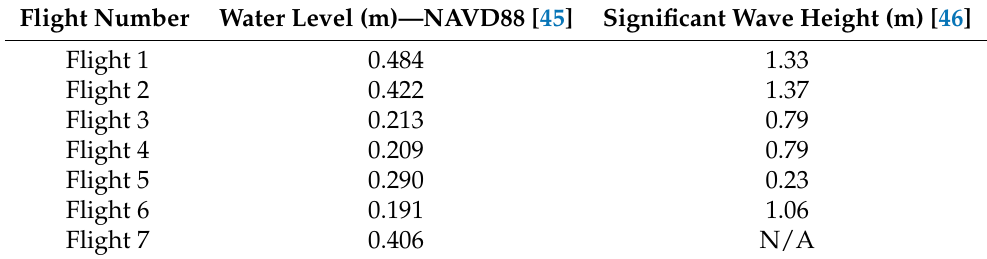
Table 3. Oceanic